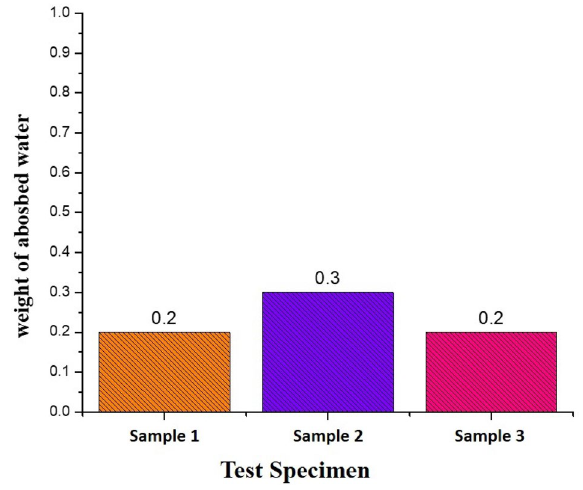
Table 8 Rain test for HDTMS- treated nonwoven cotton fabric